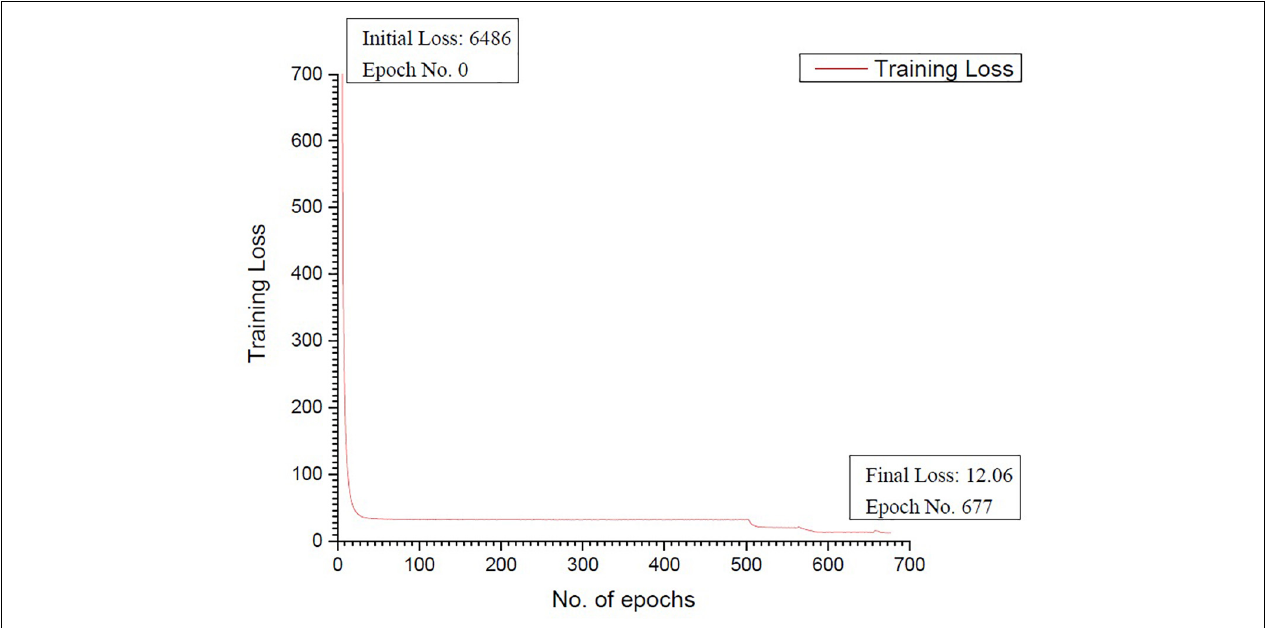
FIGURE 2 | Training loss vs. Epoch number.